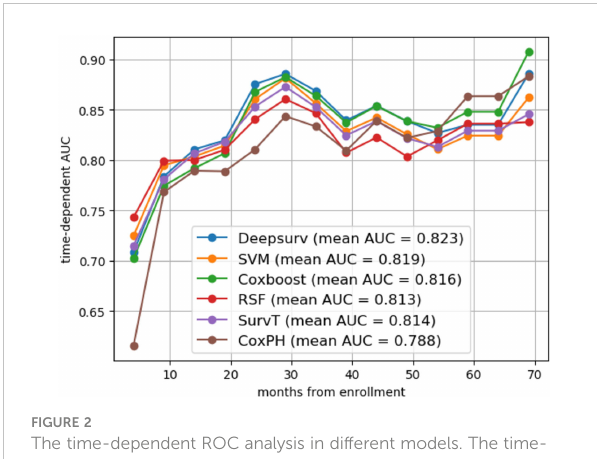
FIGURE 2 The time-dependent ROC analysis in different models. The time- dependent ROC analysis in SVM, SurvivalTree, Coxboost, RSF, DeepSurv models, CoxPH, and DeepSurv had a higher mean AUC